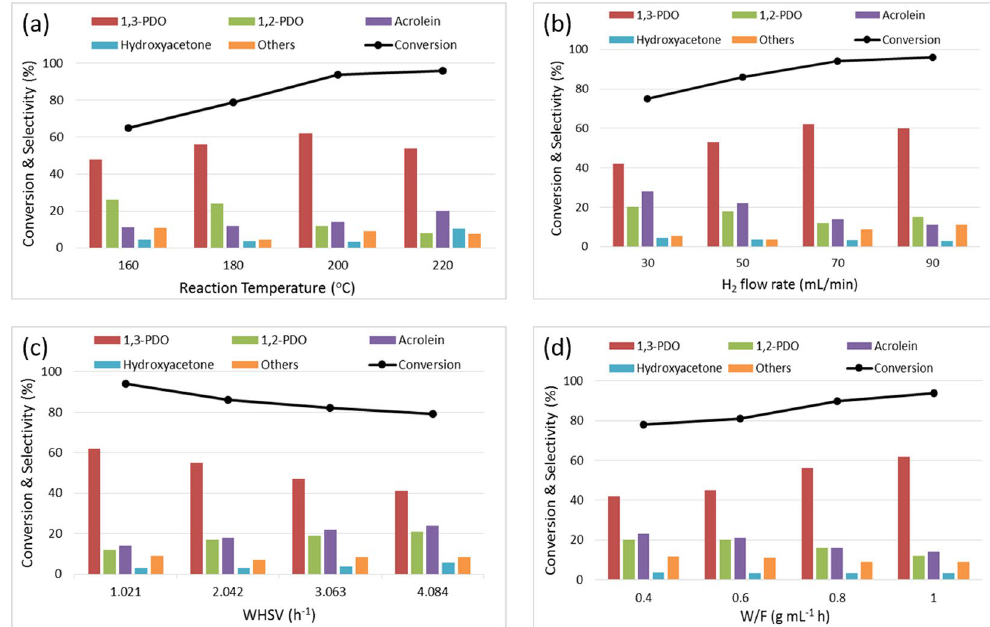
Figure 6. Effect of reaction temperature ( a ), hydrogen flow rate ( b ), weight hourly space velocity ( c ) and contact time ( d ) on glycerol conversion and product selectivity over 2Pt/S-MMT catalyst. Reaction conditions: 10 wt% glycerol aqueous solution; 0.5 g of catalyst;, 1 bar H 2 ; 1,3-PDO: 1,3-propanediol, 1,2-PDO: 1,2-propanediol, HA: Hydroxyacteone, Others include acetaldehyde, 1-propanol, acetone,